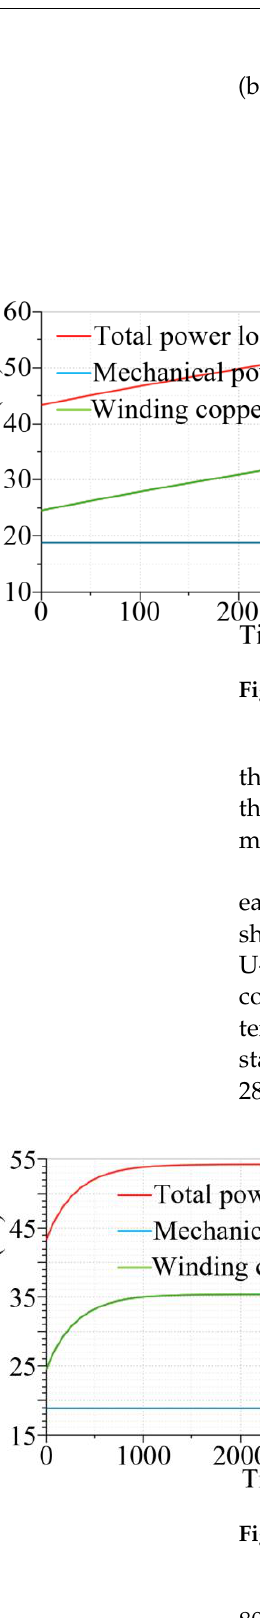
showing a good practical Figure 14. Variation of power loss and temperature over time (with the heat-conducting shell).